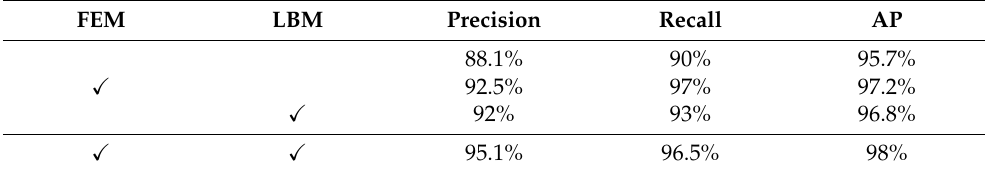
Table 6. Ablation experiment results on SSDD dataset.